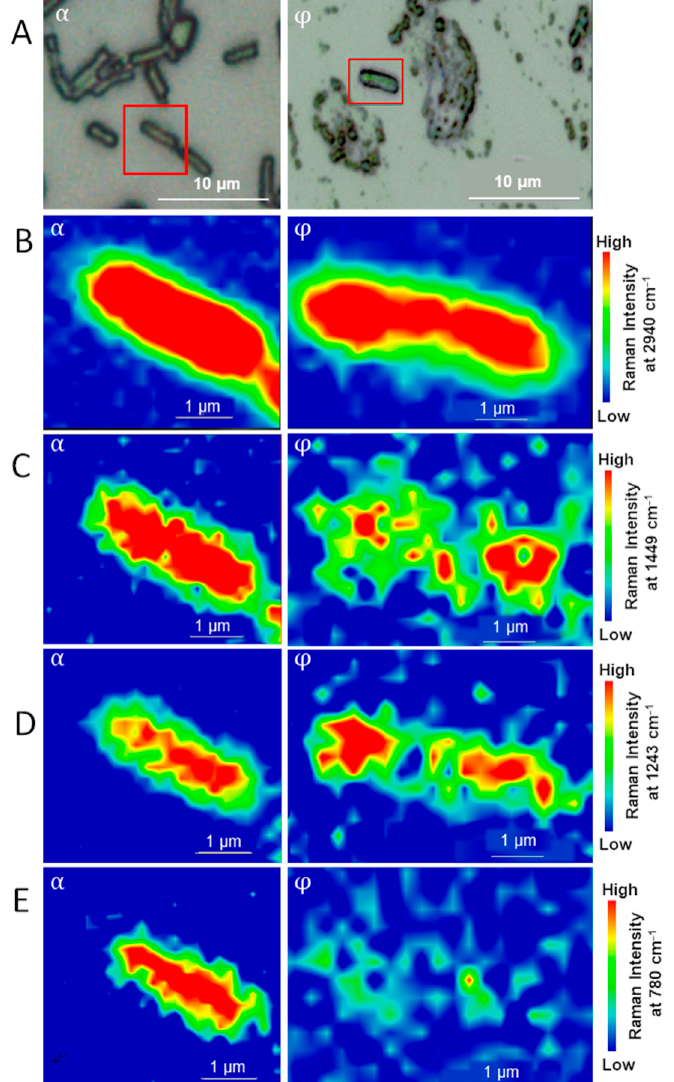
Figure 2. ( A ) Confocal Microscope image of a sample of E. coli spotted on a gold surface taken with a 100 × microscope objective. ( B ) Chemical Raman map obtained on the single bacterial cell; the color scale is based on the intensity of the Raman signal at 2940 cm − 1 of generic biomaterial. ( C ) Chemical Raman map at 1449 cm − 1 representing cell membrane. ( D ) Chemical Raman map at 1243 cm − 1 representing nucleic acids. ( E ) Chemical Raman map at 780 cm − 1 representing nucleic acids; ( α ) air-dried cell, ( φ ) freeze-dried cell.